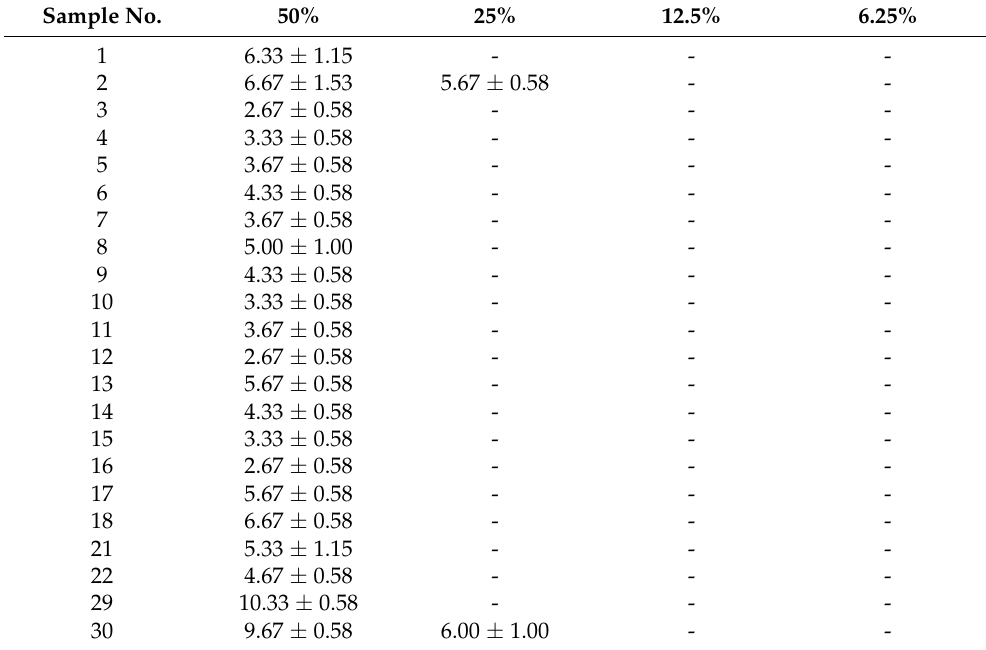
Table 1. Antimicrobial activity of samples against S. enterica in mm. Sample